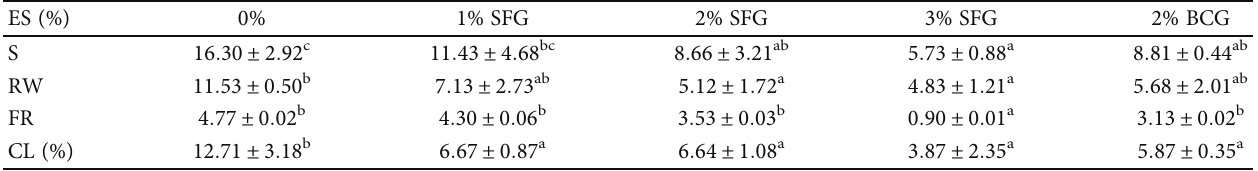
a, b, c Symbols on the same line indicate signi fi cant di ff erences ( p < 0 : 05 ). Mean ± Stdev ( n = 3 ). SFG = snakehead fi sh skin gelatin; BCG = commercial gelatin sourced from bovine bone; S = supernatant; RW = released water; FR = fat boiling process. When boiling, either water, fat, or gel solu-